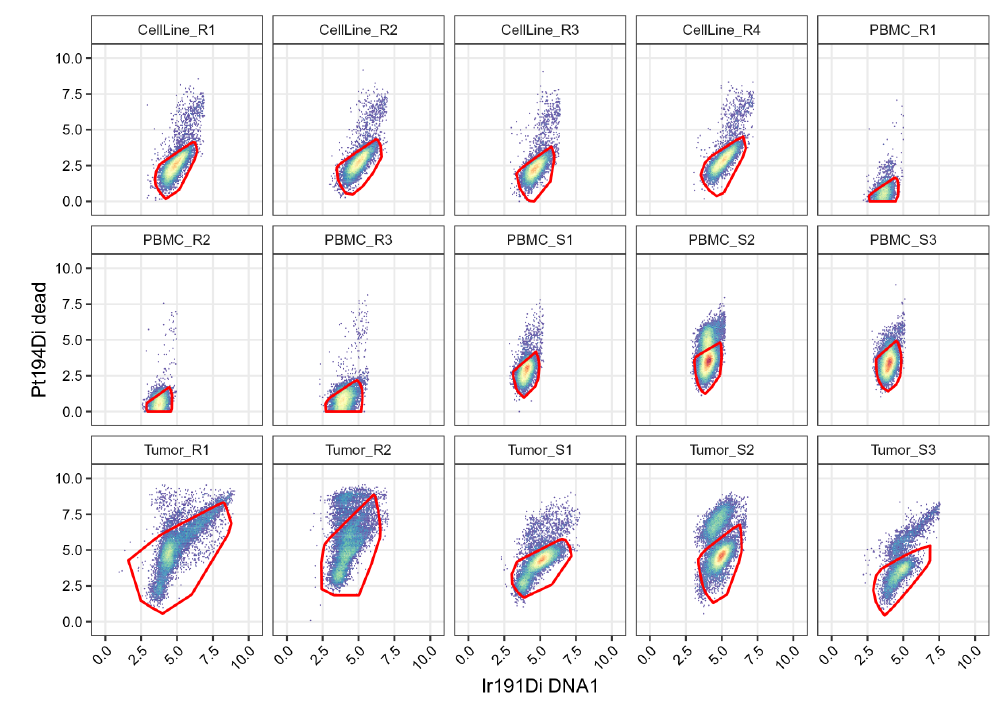
Figure 11. Scatter plots of DNA and dead cell channels, split by sample and including the live cell polygon gates. We display the yield of and gates on each samples to quickly assess the cell losses occurring "cell" "live" at the two gating steps (Figure 12). As expected the gate leads to a systematic loss of around 1% of cells "cell" across all the samples. The gate leads to a stronger reduction of cell yield in the tumor samples, consistent "live" with the fact that those samples, which underwent enzymatic dissociation, contain more dead